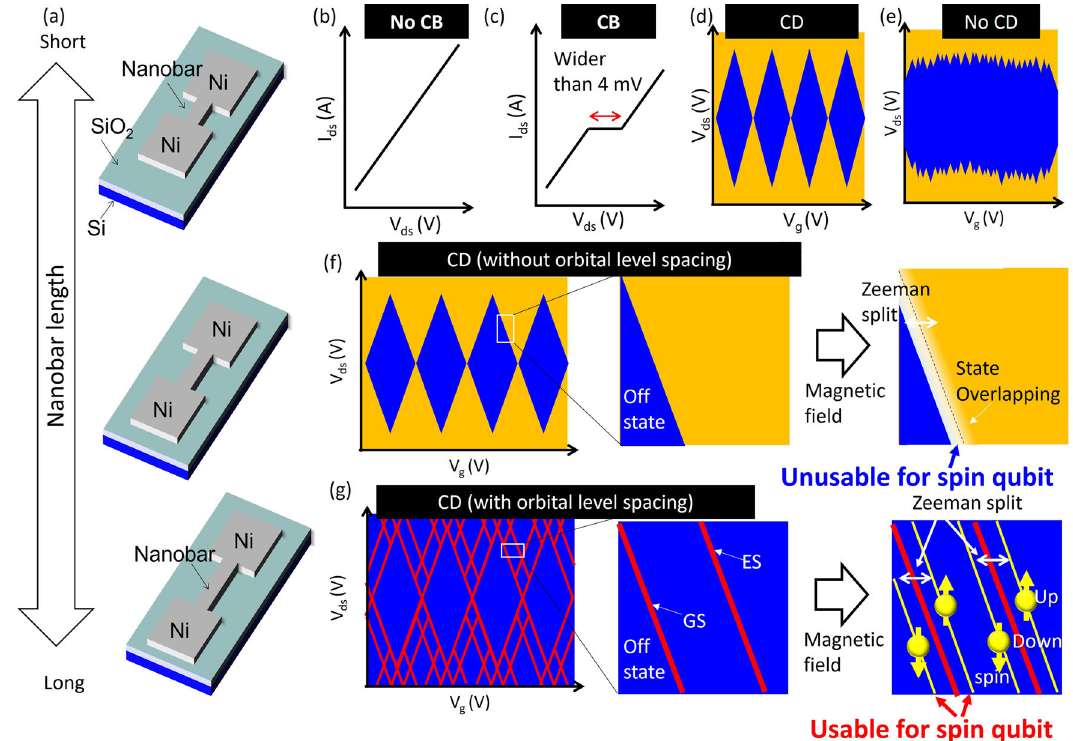
Fig. 1 Schematic illustration of GNR fabrication and categorization of quantum features. a Device structure with different L Ni values. b – e Categorization of device features for b No-CB, c CB, d CD, and e No-CD devices. f , g Difference of CD device f without and g with orbital-level